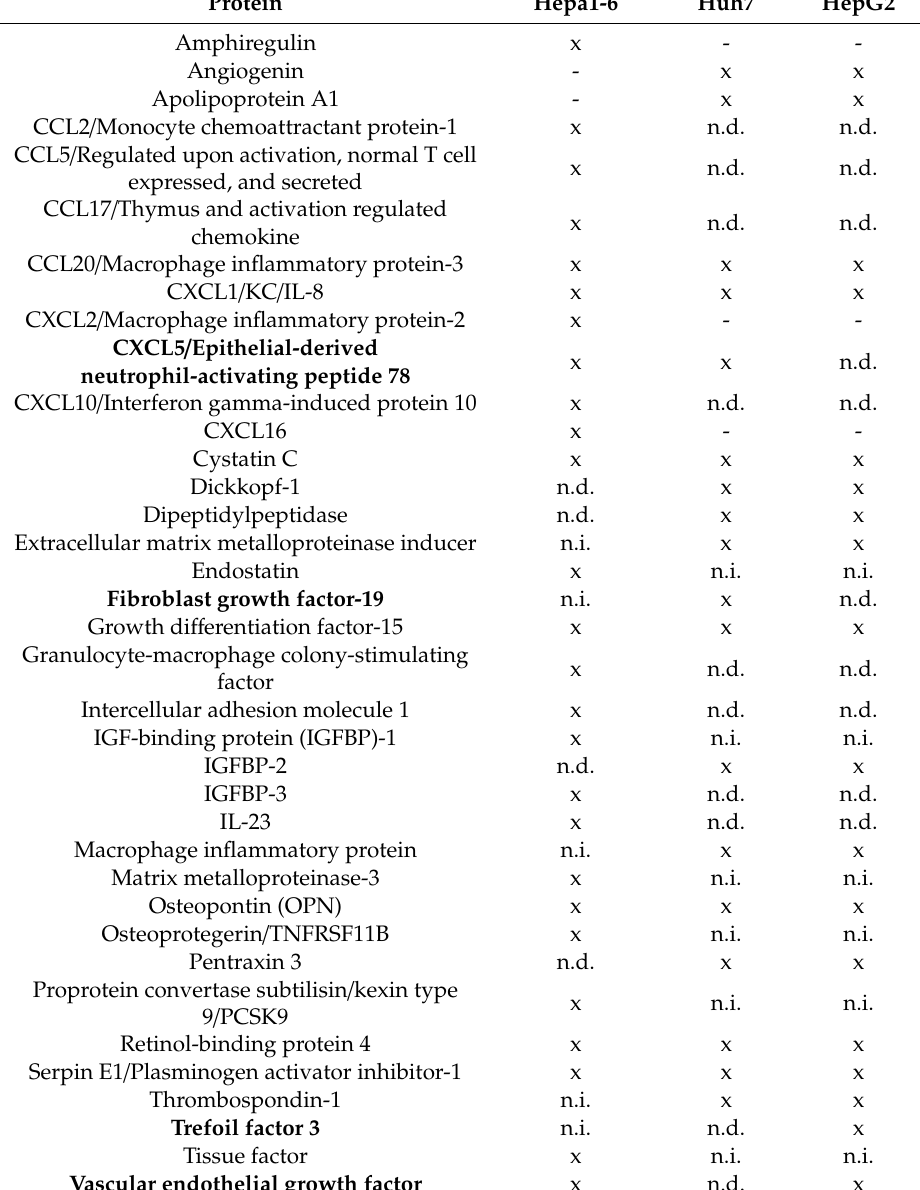
Table 1. Proteins which were detected in the media of murine and / or human hepatocytes by the respective antibody arrays are listed. A total of 37 proteins were found expressed, and 21 were detectable by the murine and the human array. The n.i. symbol indicates that antibodies to this protein were not included in this array. The proteins produced by the respective cell lines are marked with x. Proteins which were not detected in the media are marked with n. d. (not detected). Proteins produced by either Huh7 or HepG2 cells are in